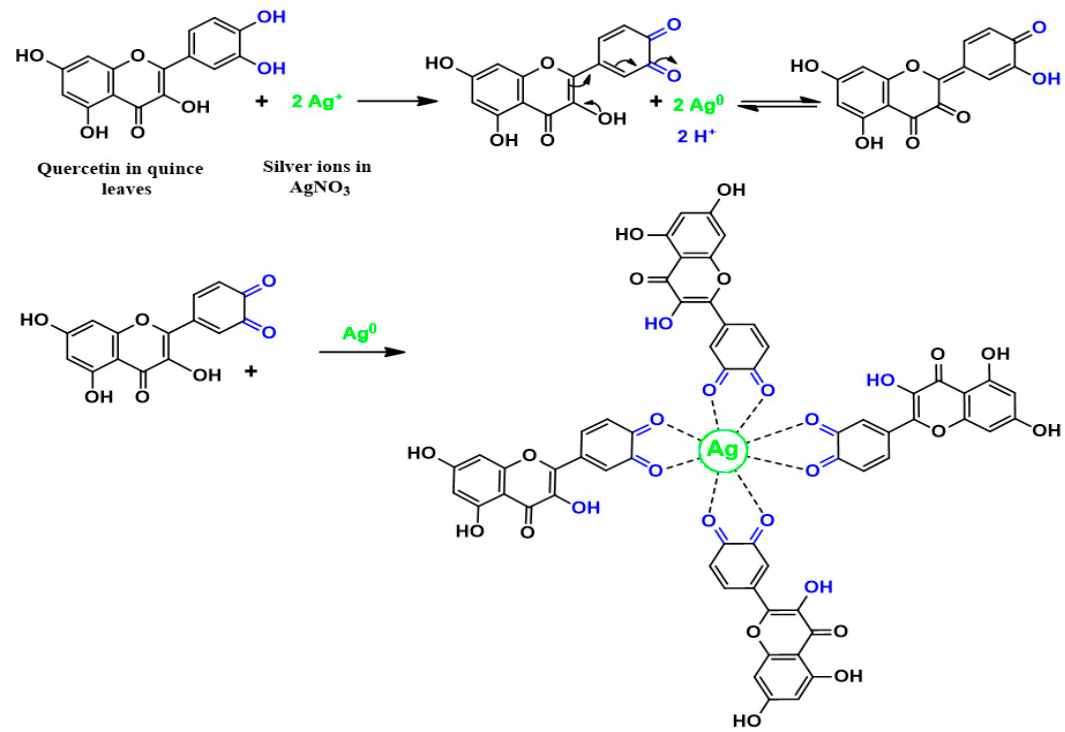
Figure 3. Mechanism for the silver ions reduction to metallic silver nanoparticles via quercetin as reducing agent in quince leaves extract solution.